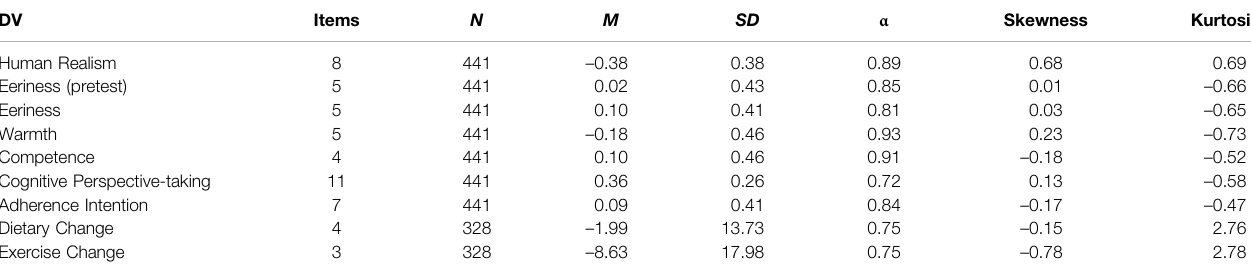
TABLE 1 | Psychometric properties of the dependent variables.